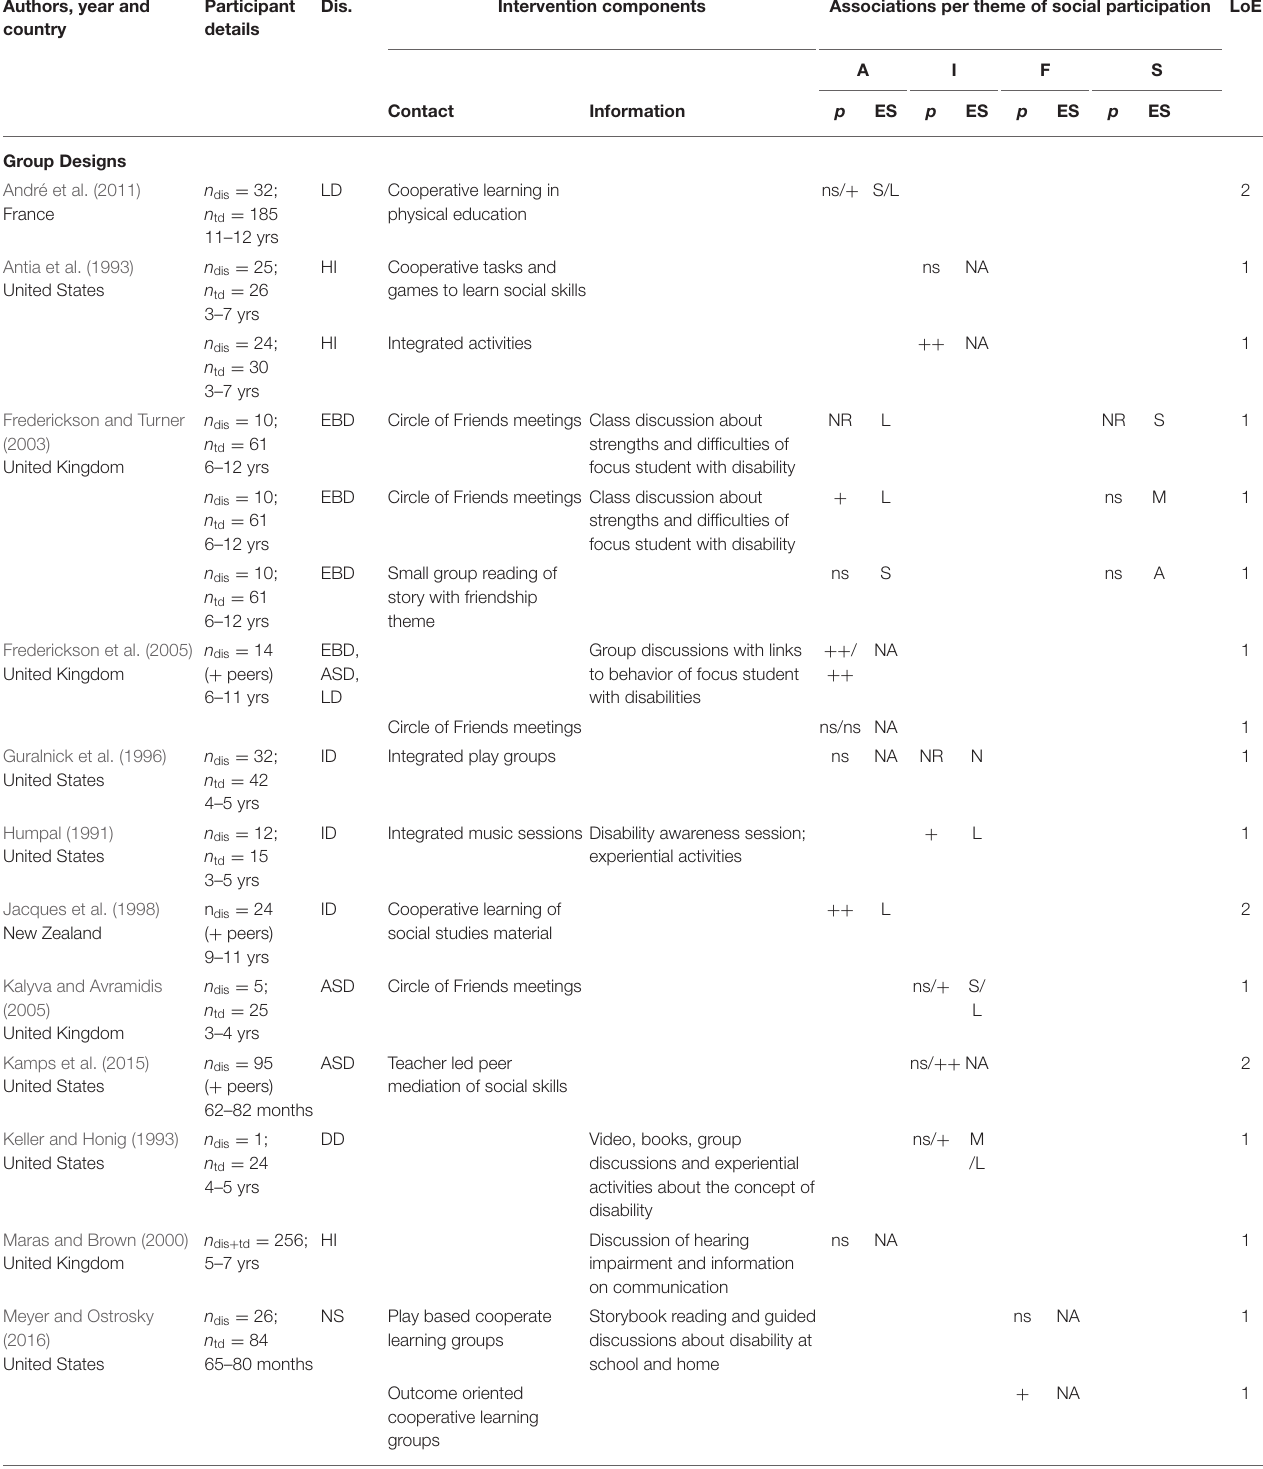
TABLE 7 | Summary of studies and interventions focusing on promoting the social participation of students with a disability. Authors, year and